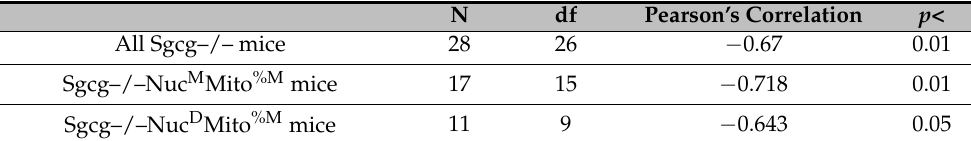
Table 2. Inverse correlation of fibronectin and the percentage of cytosines. N df Pearson’s Correlation p < All Sgcg–/– mice 28 26 − 0.67